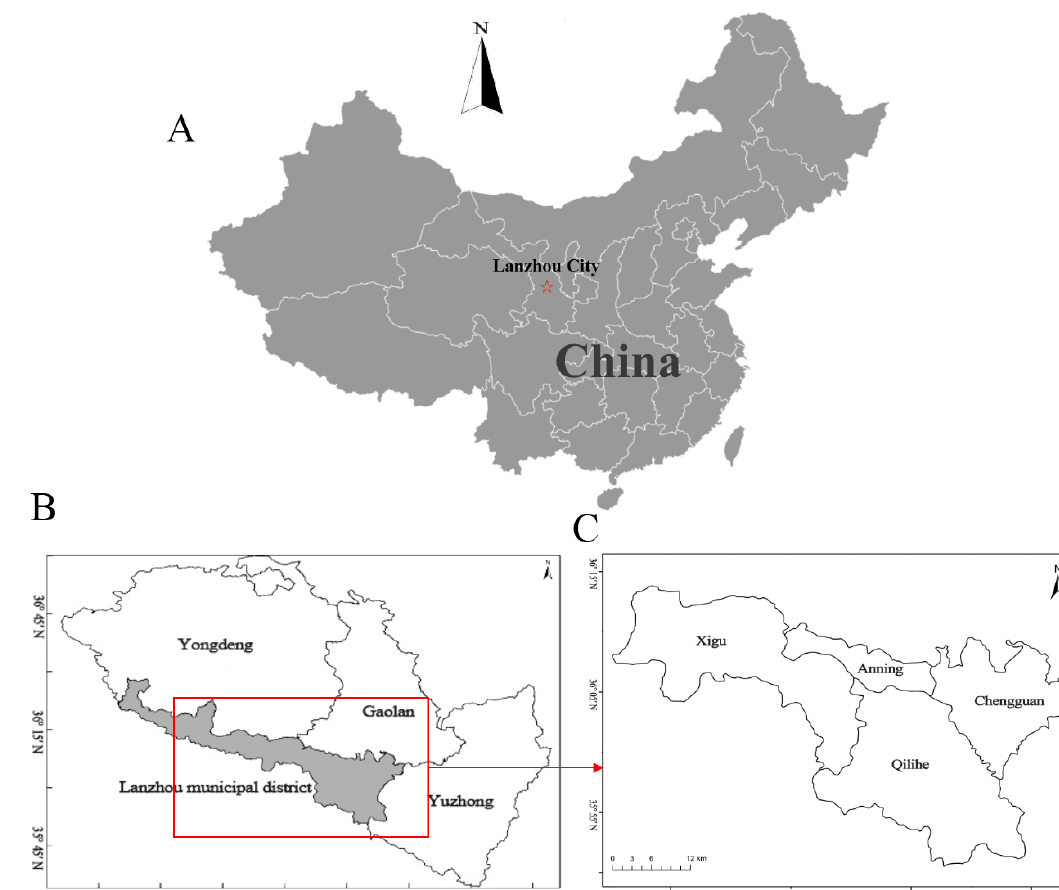
Figure 1. Geographical locations of Lanzhou City, China; ( A , B ) Locations of Lanzhou City, China; ( C ) The central four districts selected in the present